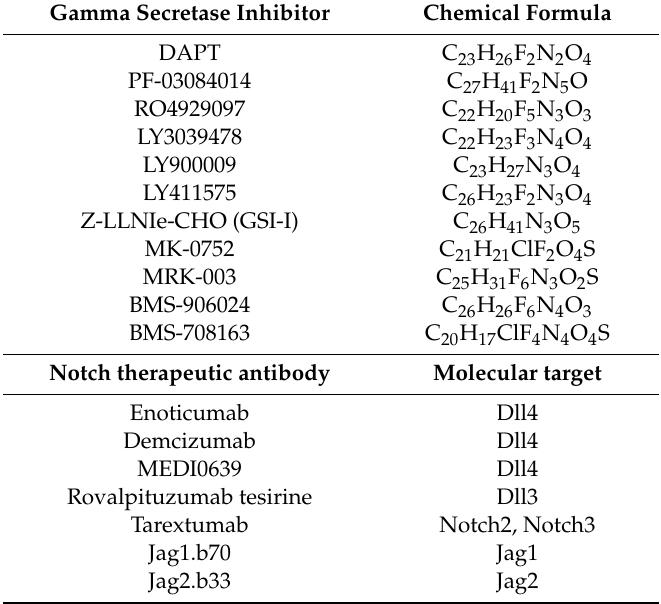
Table 2. Main gamma secretase inhibitors and Notch targeting antibodies used in clinical and subclinical studies in lung development and